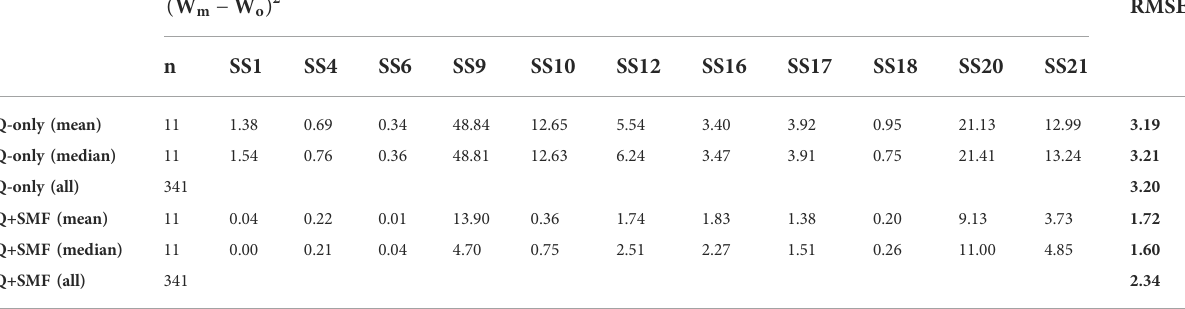
TABLE 7Rootmean squared error (RMSE) calculations for EQ-only andEQ+SMF models using mean, median, and all predictedwave heights at shore